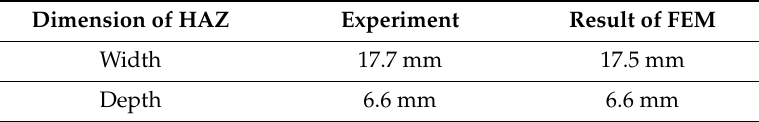
Table 9. Dimension of HAZ.